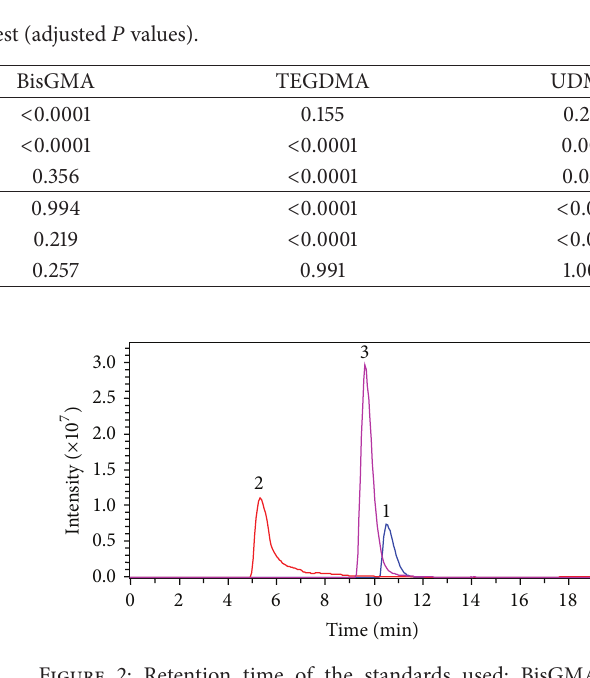
Figure 2: Retention time of the standards used: BisGMA (1), TEGDMA (2), und UDMA (3).